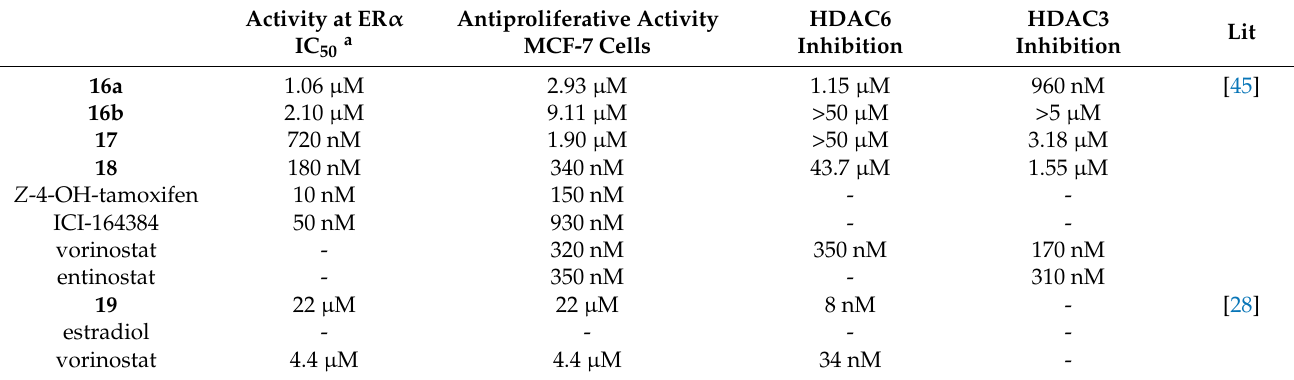
Table 4. Pharmacological actions of selected drug conjugates incorporating